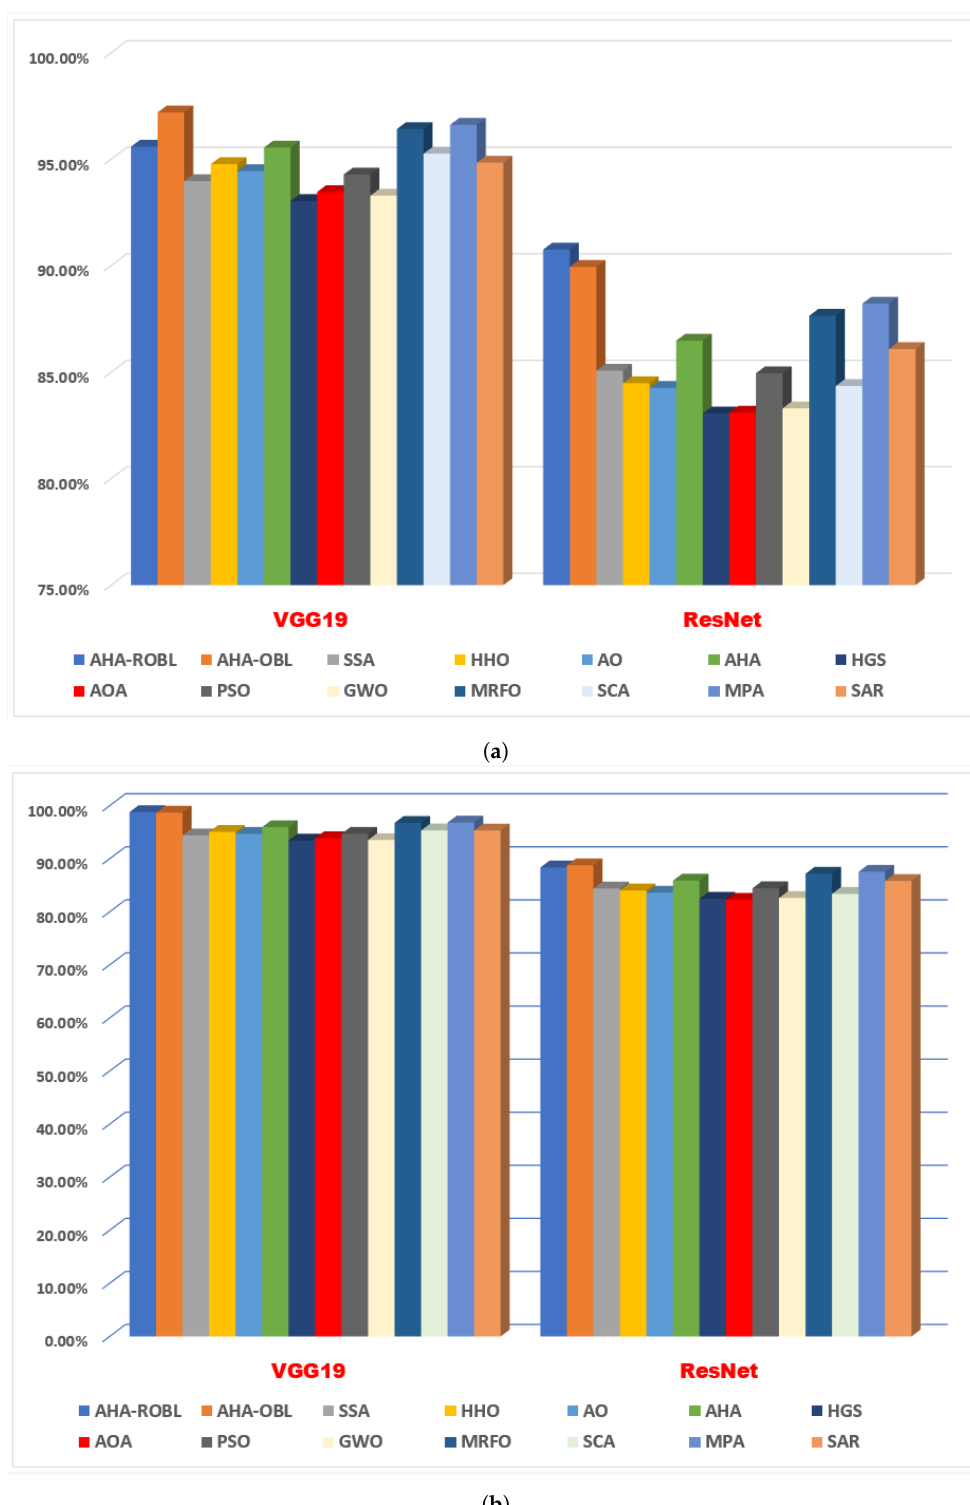
Figure 10. ( a ) Avg. F-score of the proposed approaches versus other algorithms using VGG19 and ResNet20 and ( b ) avg. sensitivity of the proposed approaches versus other algorithms using VGG19 and